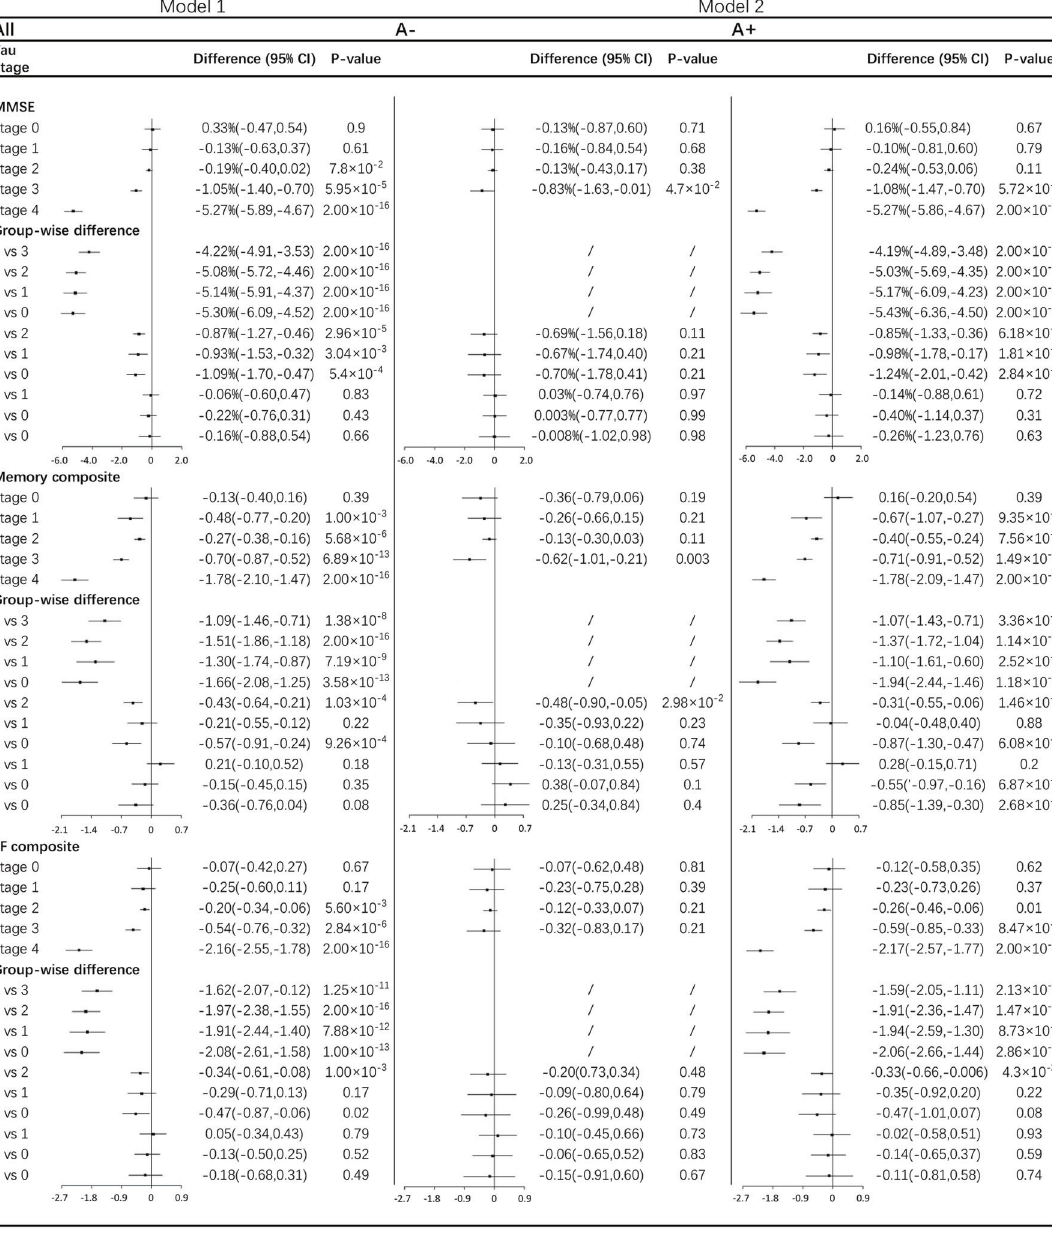
expressed as % per year for MMSE and 10 − 1 per year for Memory or EF composite with 95%CI. The numbers of participants included and comparisons between the A + and A − within the same stage are shown in Supplementary Table 3 and Supplementary Table 4 for